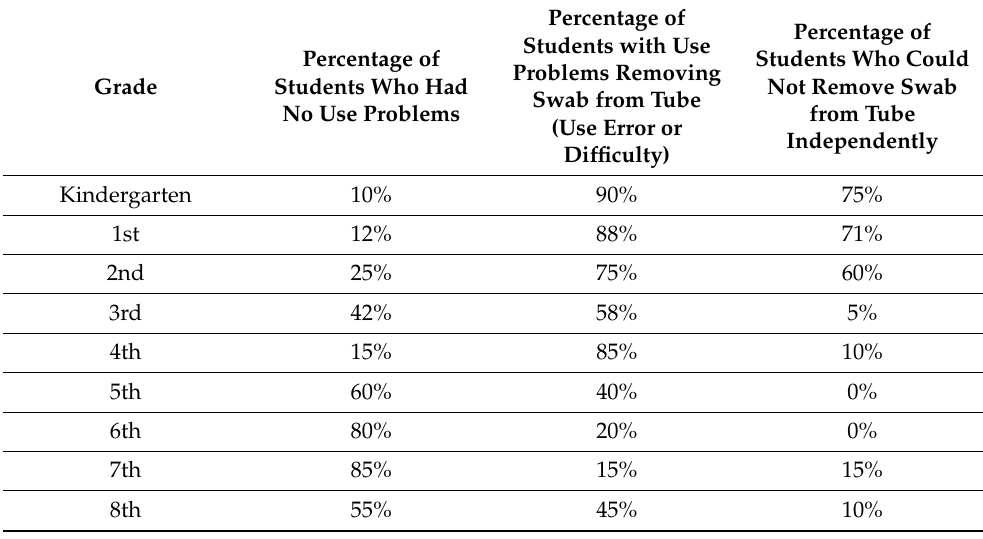
Figure 9. Comparison of observed use problems between XpressCollect and modified swab concept B in Phase 4. 3.5. Phase 3 and 4 Performance Comparison To compare the influence of class size on the students’ performance, the observed use problems for each task from the students in Phases 3 and 4 are plotted in Figure 10. There were no significant differences in observed use problems when students were in a full classroom versus small groups.